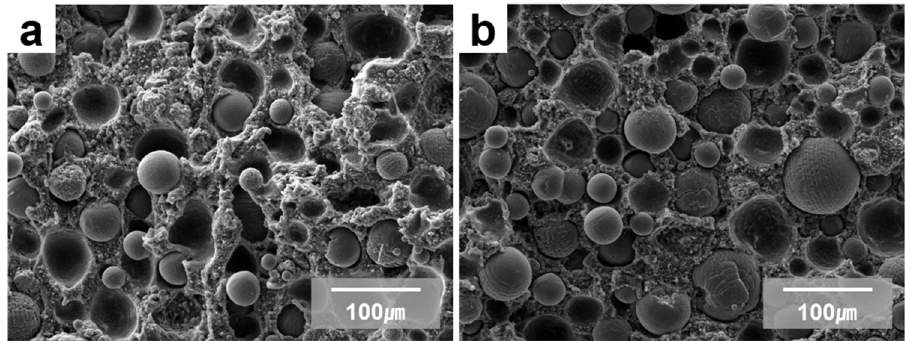
Figure 2. Cross-sectional SEM images of thermal pads using aluminum oxide powder of ( a ) type B and ( b ) type E.